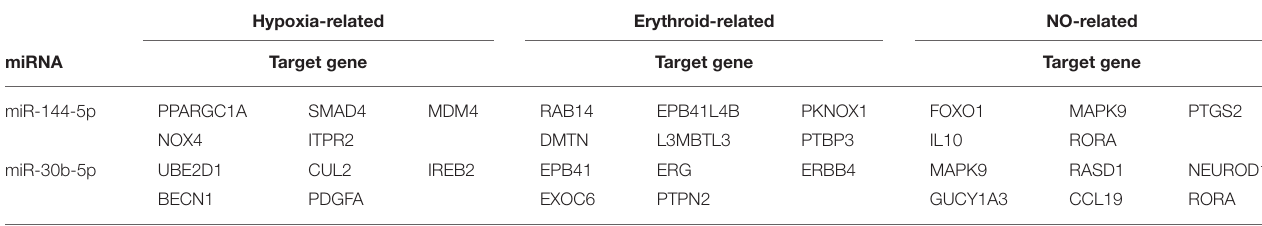
TABLE 2 | Predicted target genes of miR-144-5p and miR-30b-5p. Hypoxia-related Erythroid-related